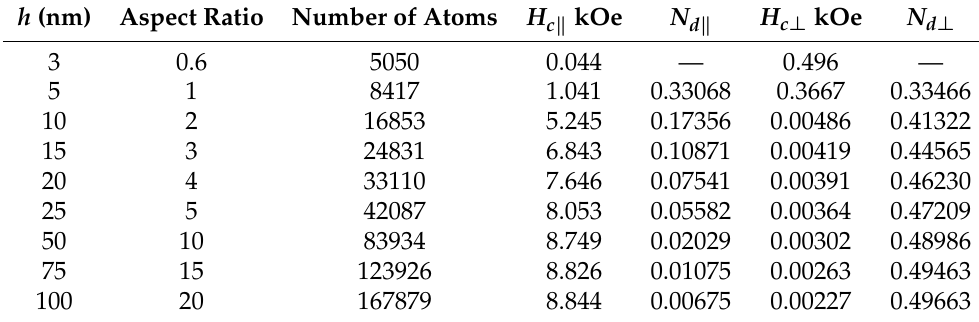
Table 1. The values of coercive field and demagnetization coefficients (for the magnetic field applied parallel and perpendicular to the main axis of nanoobjects) for cylindrical nanostructures as a function of aspect